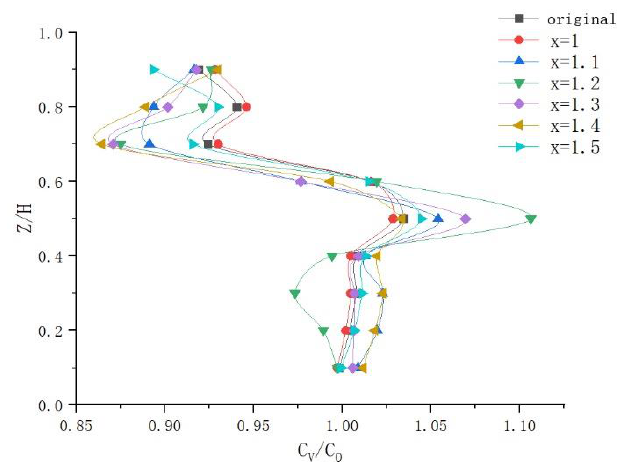
Figure 16. Optimization of the scale-up index at 10% v/v .